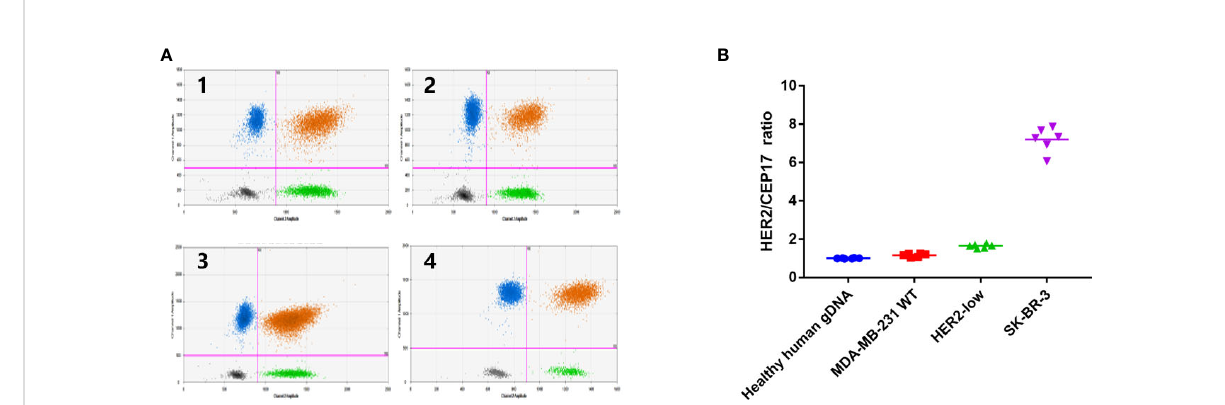
FIGURE 3 Monoclonal cultured cells assigned by ddPCR. (A) Data was shown in the form of 2D amplitude of Bio-Rad droplet digital PCR. The number of microdroplet generated by all reactions was more than 10000, in accordance with Poisson distribution statistical principle, and the fl uorescence of FAM (HER2) and VIC (CEP17) was clearly distinguished. і :Healthy human gDNA; ii: MDA-MB-231 WT cells; iii: HER2-low cells; iv: SK-BR-3 cells, (B) Data shown in the form of ratio (HER2/CEP17). The HER2/CEP17) ratios of healthy human genomic DNA, MDA-MB-231 cell line, HER2- low cells and SK-BR-3 cell line were 1.001 (0.982-1.026), 1.1638 (1.033-1.254), 1.693(1.632-1.775) 7.194